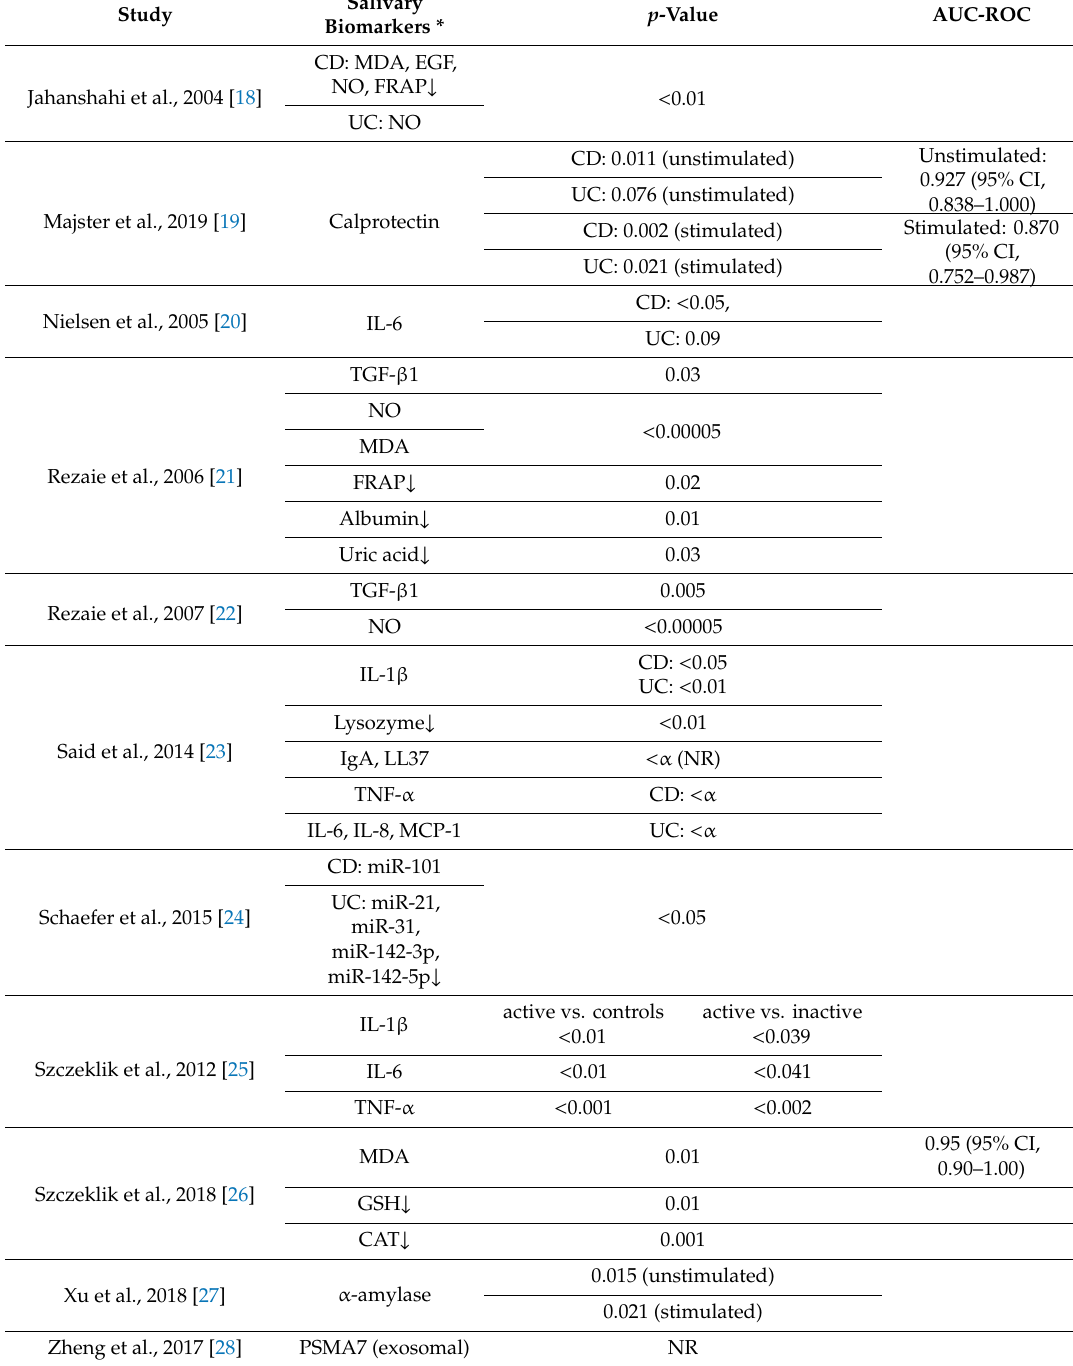
Table 3. Statistical significance for salivary biomarkers in